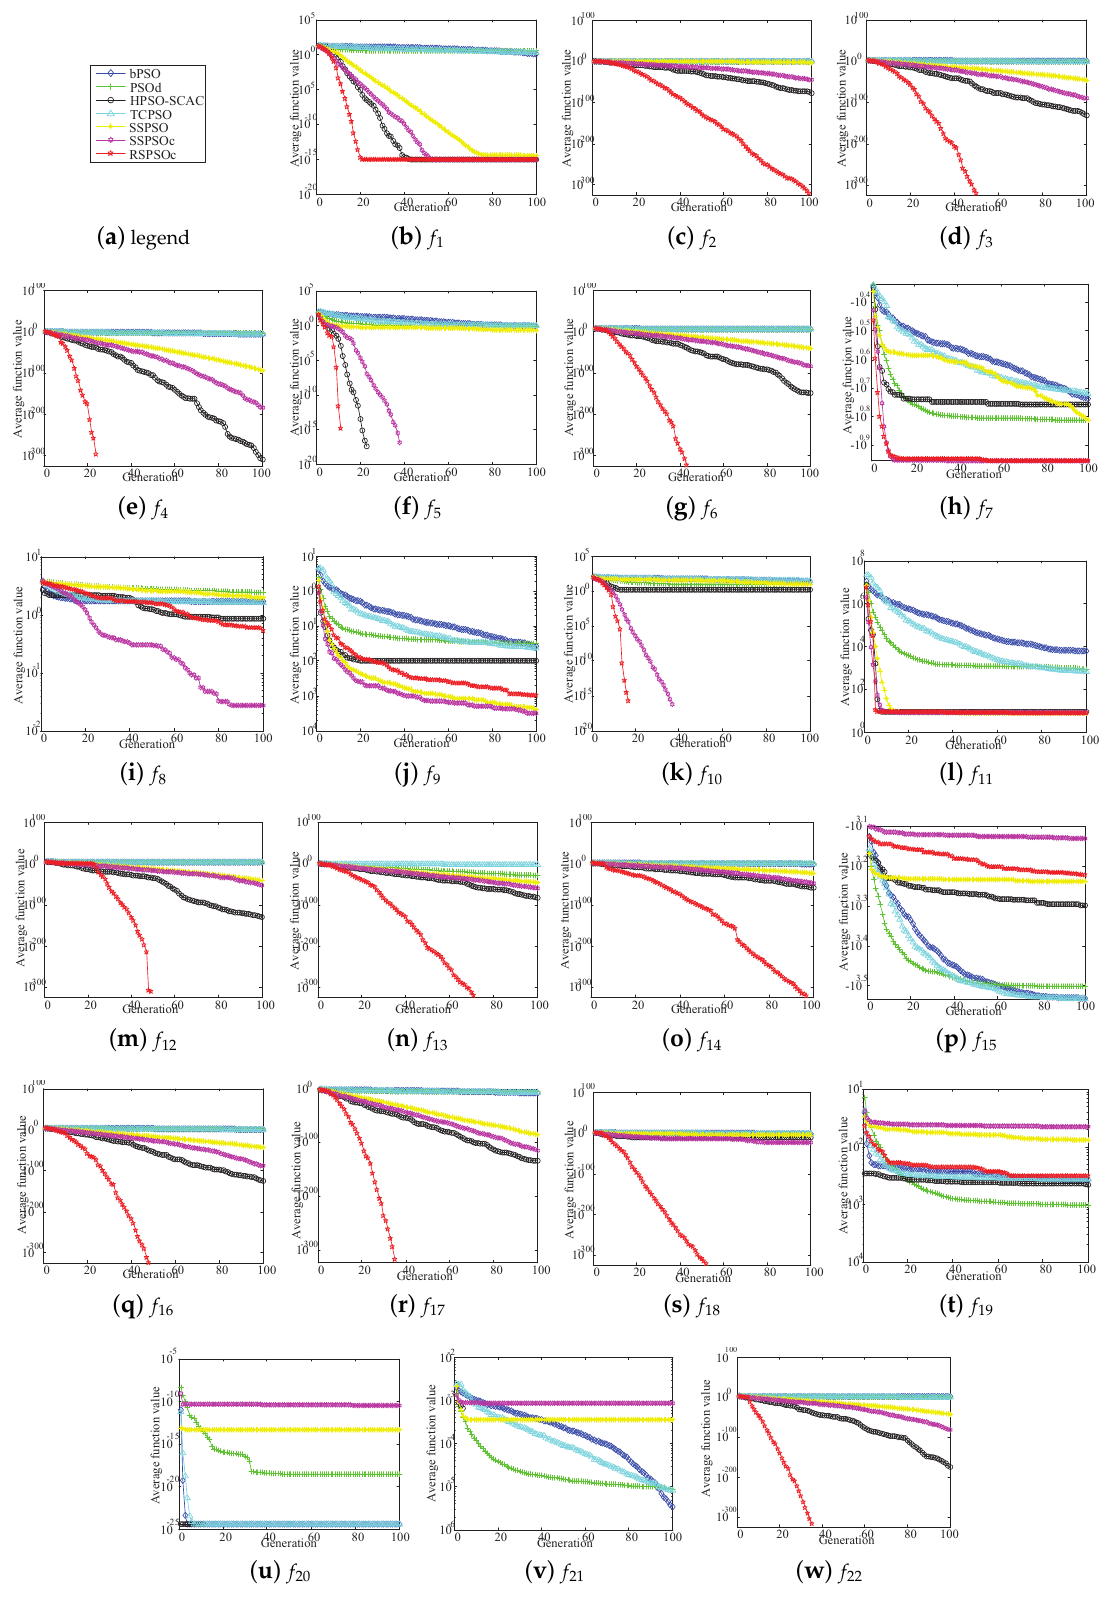
Figure 4. Average convergence curves of seven improved PSO algorithms for twenty-two functions in 10